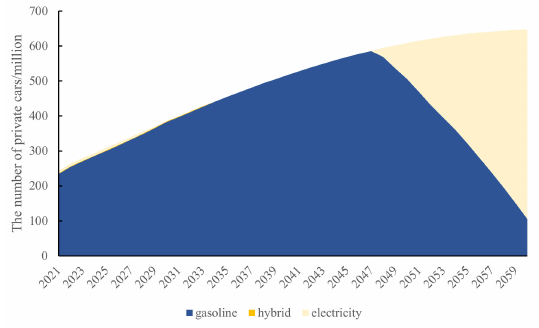
Figure 8. The number of private